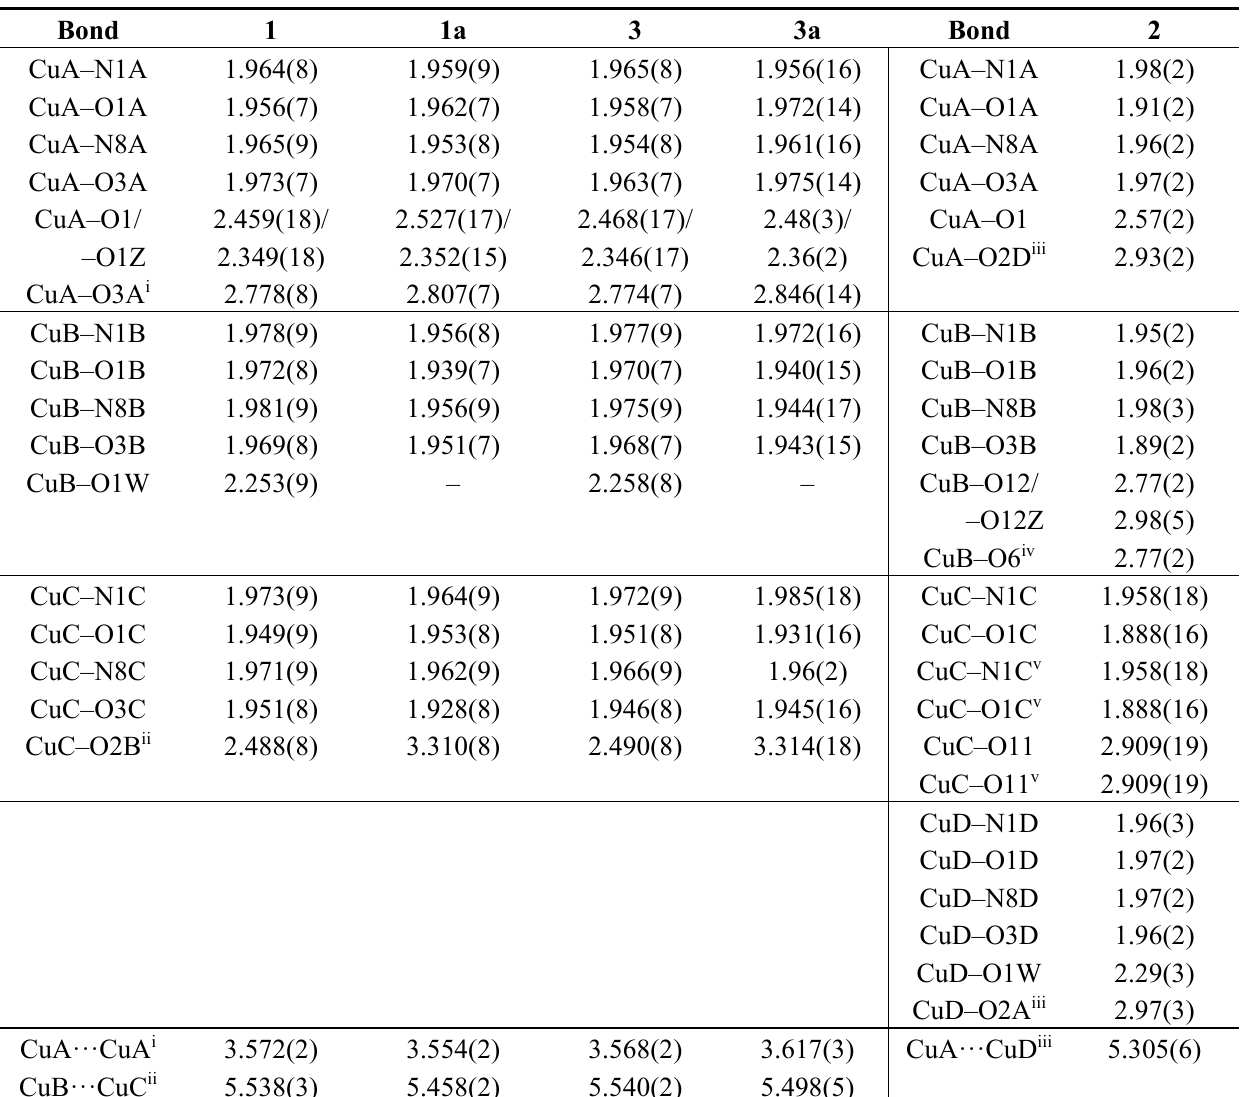
Table 1. Bond lengths and intradimeric Cu···Cu distances (Å) for the copper(II)-picolinate complexes in 1 – 3 compared to those in the anhydrous phases 1a and 3a